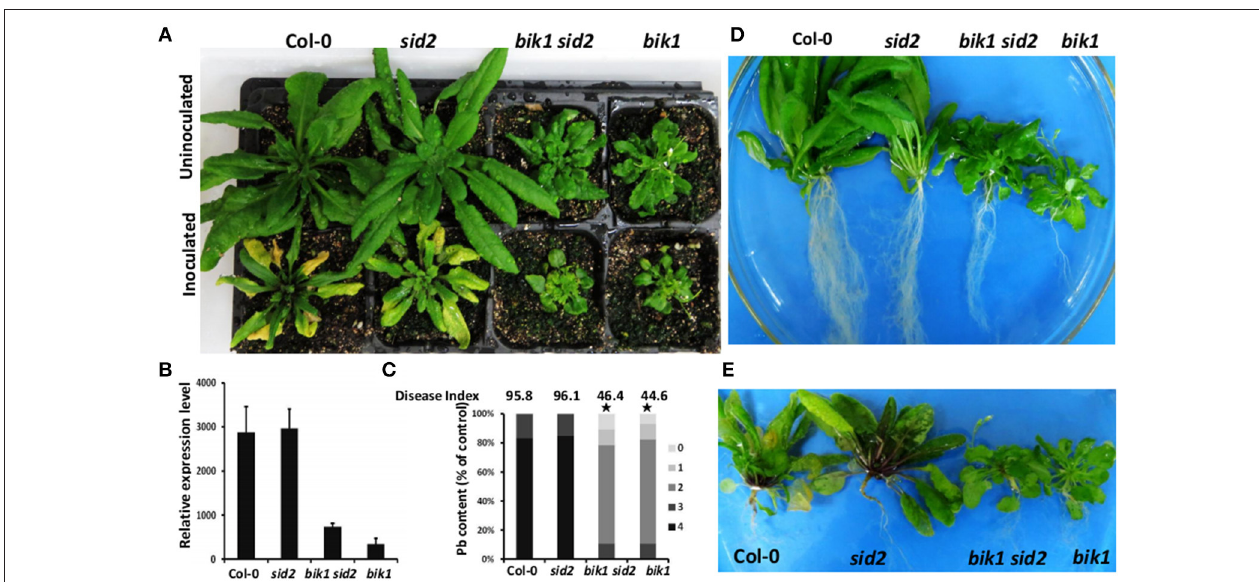
FIGURE 7 | Effect of sid2 mutation on bik1 -mediated resistance against P. brassicae. (A) Mature shoot phenotypes of wild type and mutant plants. The top of the picture shows uninoculated plants, while the bottom shows plants inoculated with P. brassicae. (B) Real-time PCR analysis was performed to assess the expression levels of P. brassicae at 28 days after inoculation with P. brassicae. (C) Phytopathological analysis of wild type and mutant plants. The percentages of plants in the individual disease classes are shown. 0, no symptoms; 1, very small galls mainly on lateral roots and that do not impair the main root; 2, small galls covering the main root and few lateral roots; 3, medium to large galls, also including the main root; and 4, severe galls on lateral root, main root or rosette; fine roots completely destroyed. For each treatment, 26–30 Arabidopsis plants were analyzed. The qualitative disease assessment data were initially analyzed using spss and subsequently further analyzed after comparing the mean rank differences. The asterisk indicates a significant difference at P < 0.01. The disease index for each sample is shown as a number above the respective histograms. (D) Images of the shoots without inoculation are shown in (A) . (E) Clubroot symptoms in plants. Images of the shoots with inoculation are shown in (A)